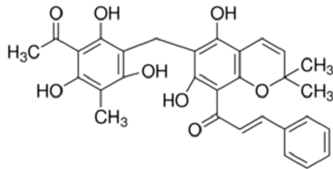
Figure 1. Chemical structure of rottlerin.